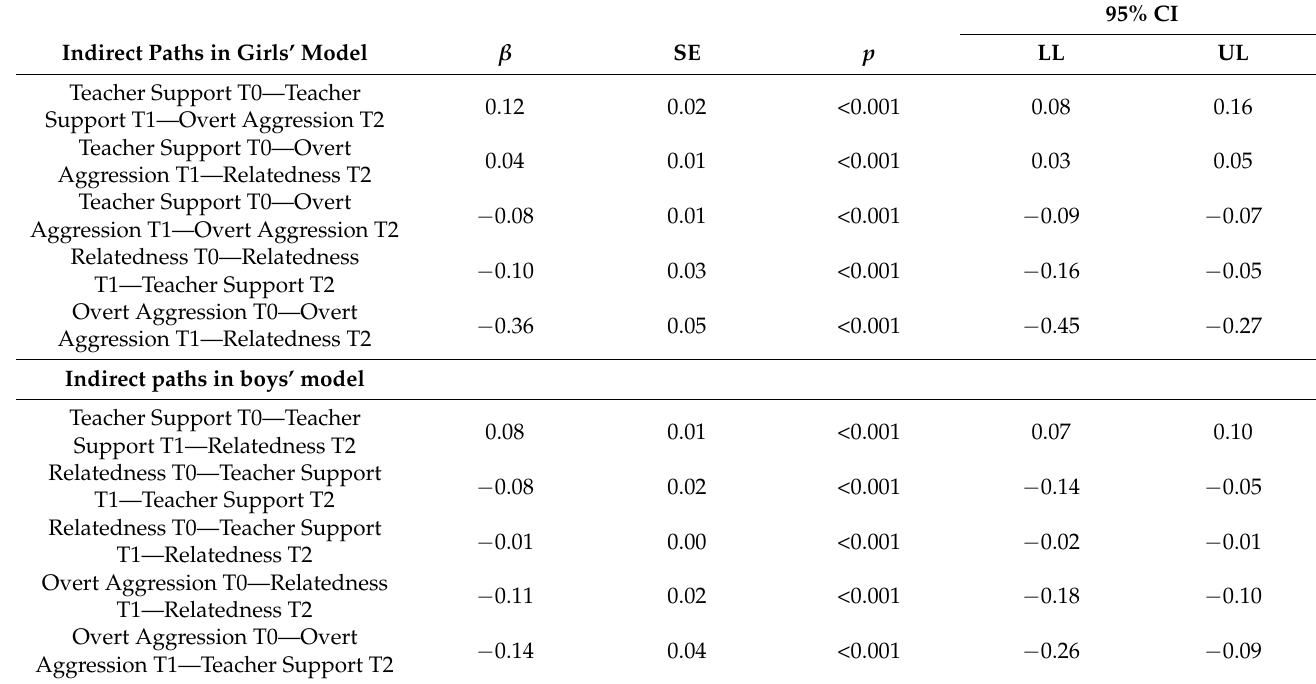
Table 3. Indirect effects in the overt aggression